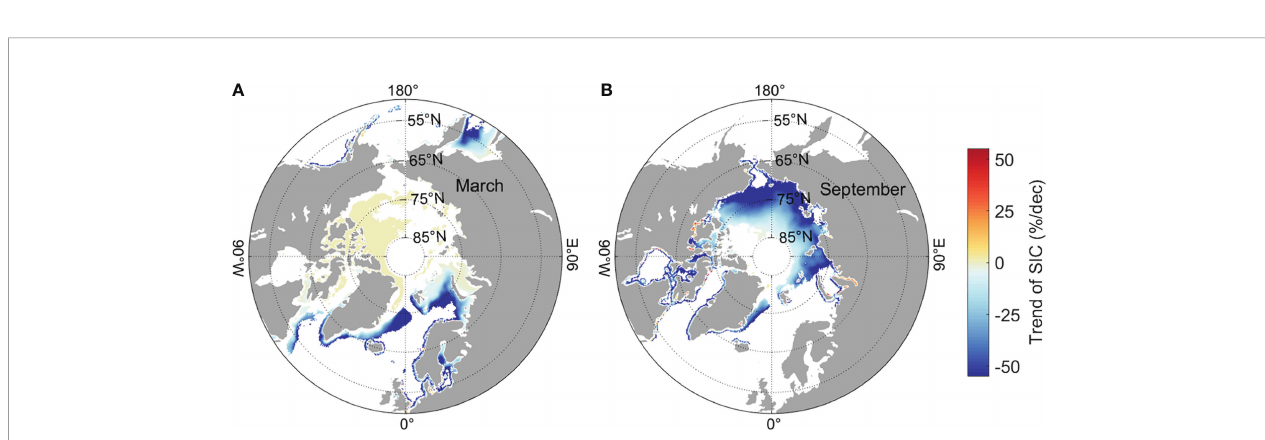
FIGURE 2 | Multi-decadal trend of the Arctic sea ice concentration (SIC) in March (A) and September (B) during 1979 – 2020. Only trends that are signi fi cant at 95% con fi dence level based on Mann-Kendall test are shown. Data are obtained from